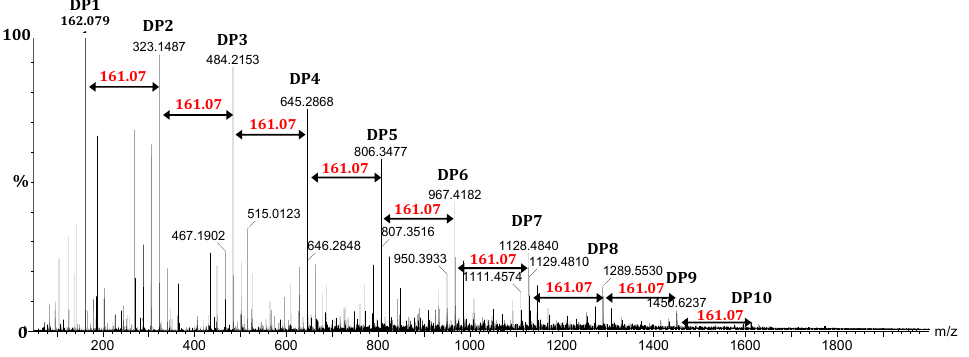
Figure 3. Electrospray-ionization high resolution mass spectrometry (ESI-HRMS) analysis of chitosan oligosaccharides obtained from fungal chitosan by an acetic acid hydrolyzed method using an autoclaving-cooling process (10 cycles, 30 min at 121 °C and 15 min cooling).